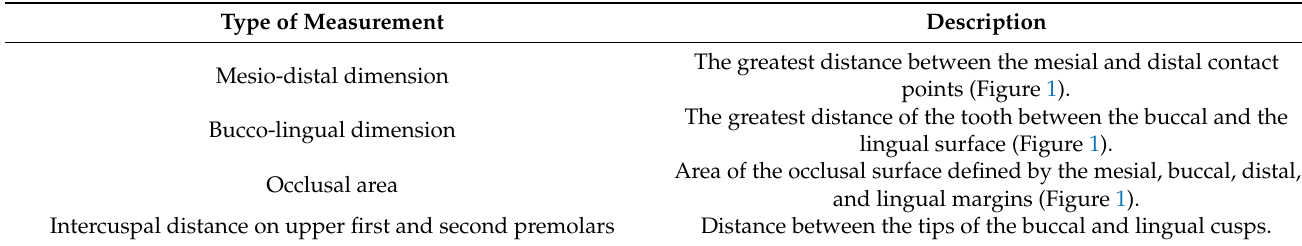
Table 1. Description of the morphometric